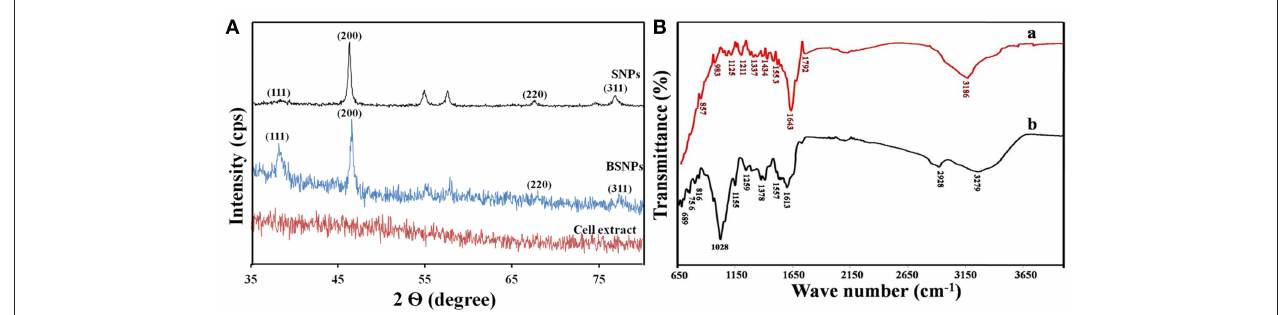
FIGURE 3 | Structural and biochemical characterization. (A) XRD spectrum showing the face centered cubic (FCC) nature of the SNPs, BSNPs and cell extract. (B) FTIR spectra of (a) BSNPs and (b) cell extract.